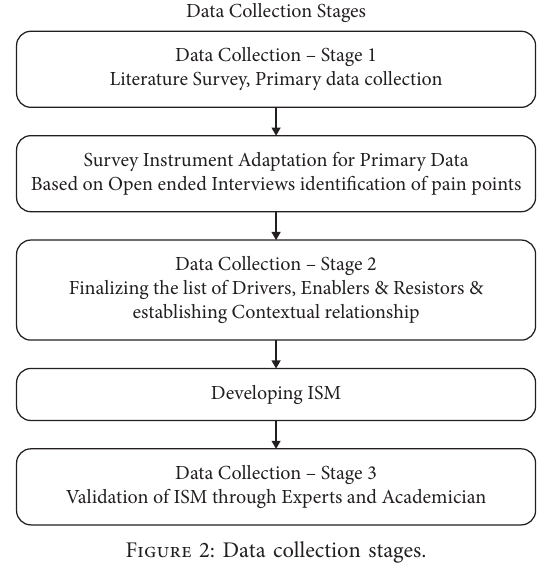
Figure 2: Data collection stages.